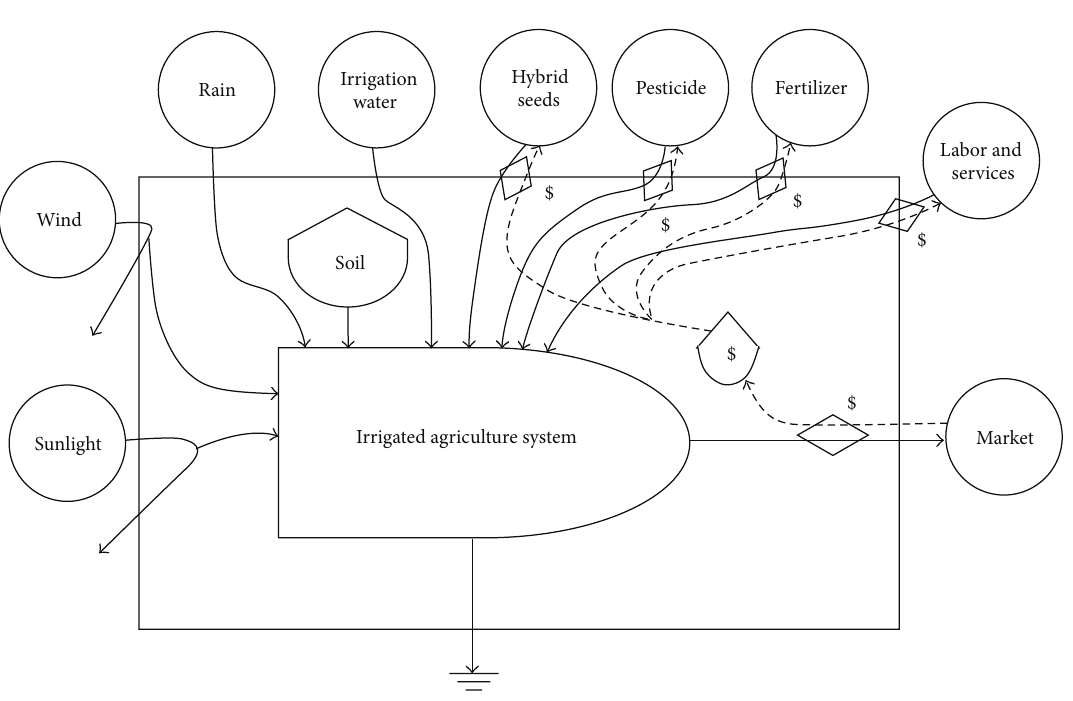
Figure 3: Energy systems diagram of the irrigated agriculture